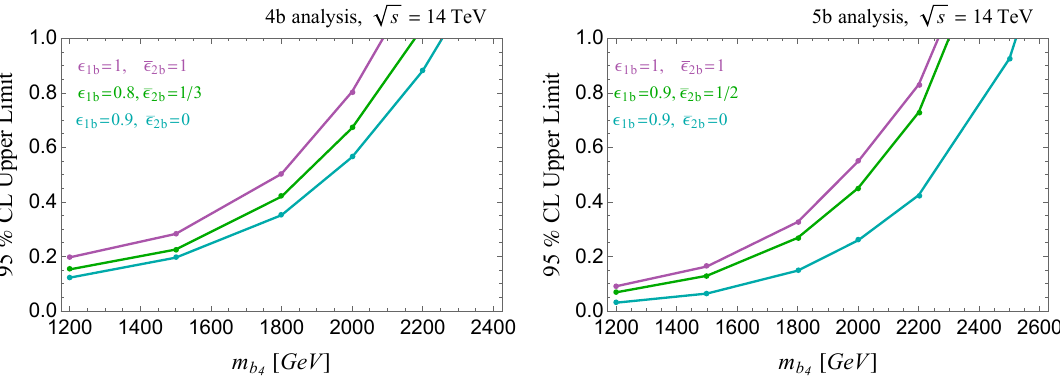
Figure 12 . Left: impact of 1b/2b tagging e(cid:14)ciencies on the 4b analysis. In purple, we show the Hb bbb branching ratio with m H = 1 TeV assuming no expected 95% CL upper limit on the b 4 ! ! discrimination between genuine b-jets and bb-jets. In green we show the optimal tagging e(cid:14)ciencies used in the main results. We show the e(cid:11)ect of perfect discrimination of 2b-jets in Cyan. Right: corresponding study of tagging e(cid:14)ciencies in the 5b